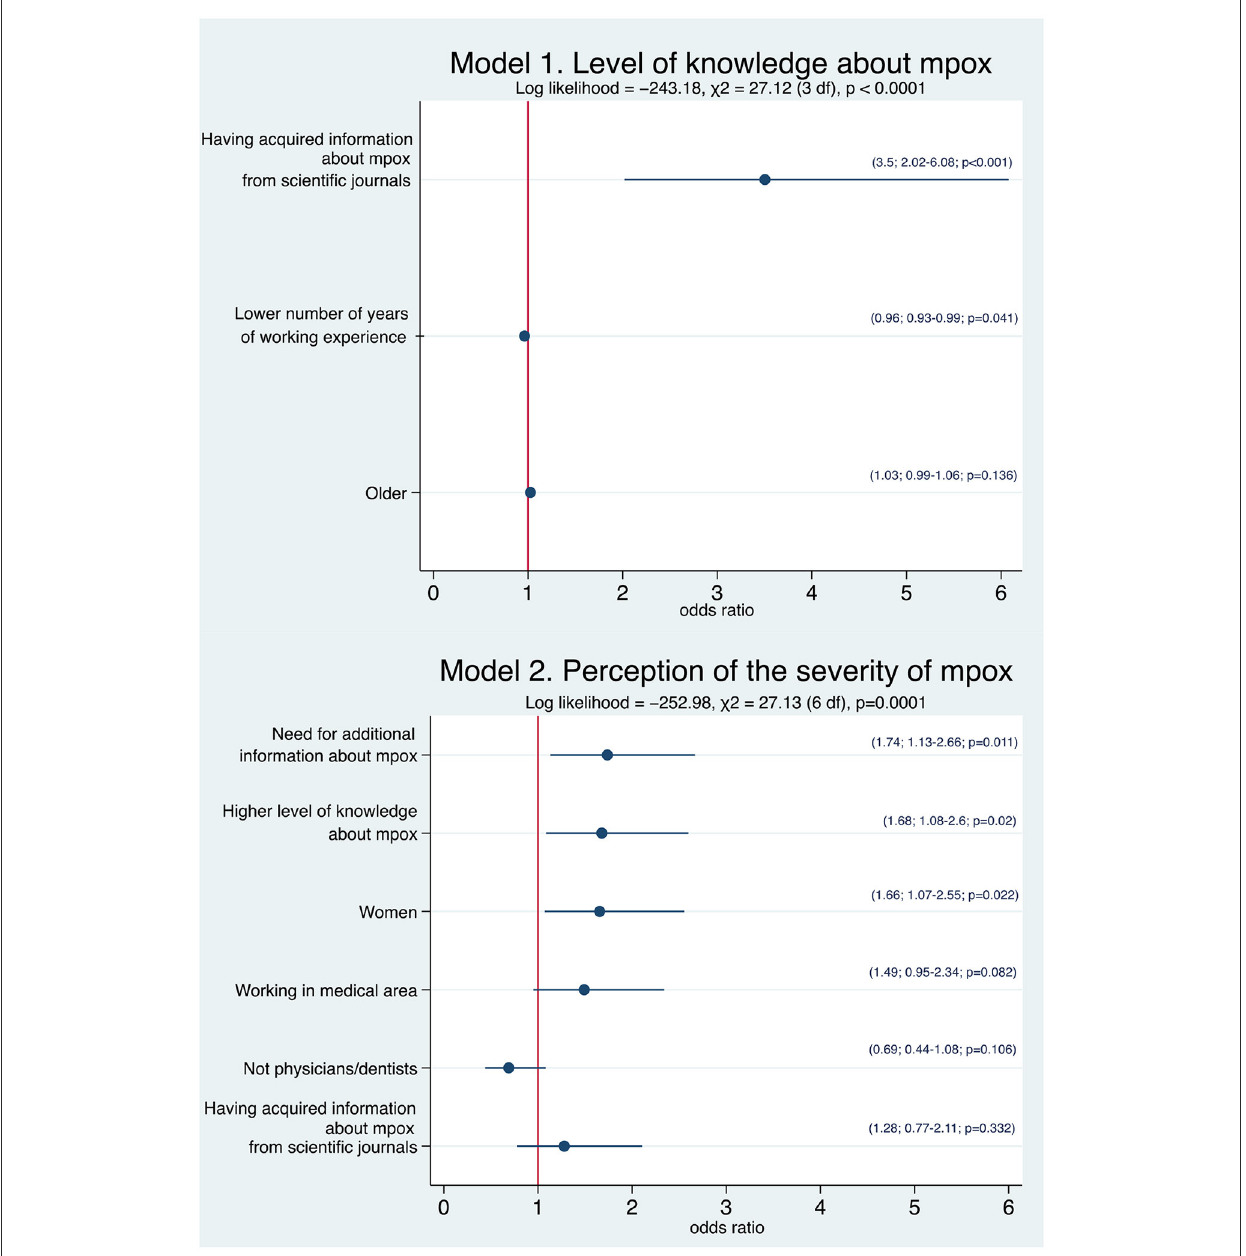
FIGURE1 Forest plot of the associations of the several explanatory variables and the different outcomes of interest using multivariate logistic regression analysis. Circles represent the odds ratio for each individual variable and horizontal lines indicate 95% confidence interval. In brackets are reported odds ratio, 95% confidence interval, and p- value.